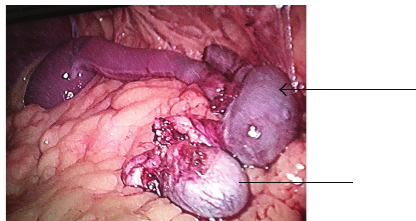
Figure 2: Laparoscopic assessment picture showing splenogonadal fusion (splenic portion marked with arrow-line and testicular portion marked with line only).